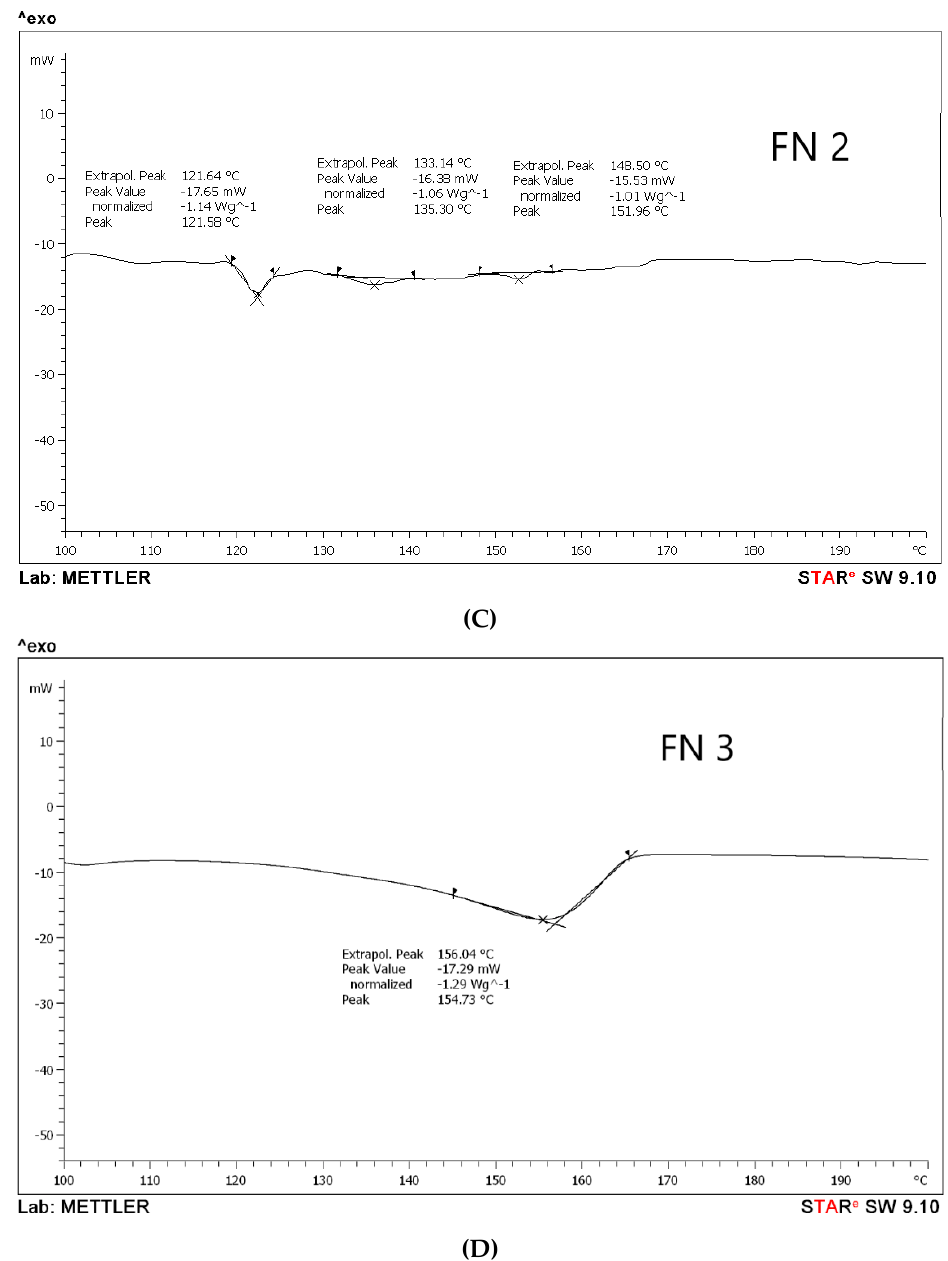
Figure 2. Di ff erential scanning calorimetry (DSC) thermograms of ( A ) pure drug, ( B ) formula with glucose as a carrier (FN1), ( C ) formula with maltodextrin as a carrier (FN2), and ( D ) formula with mannitol as a carrier (FN3).